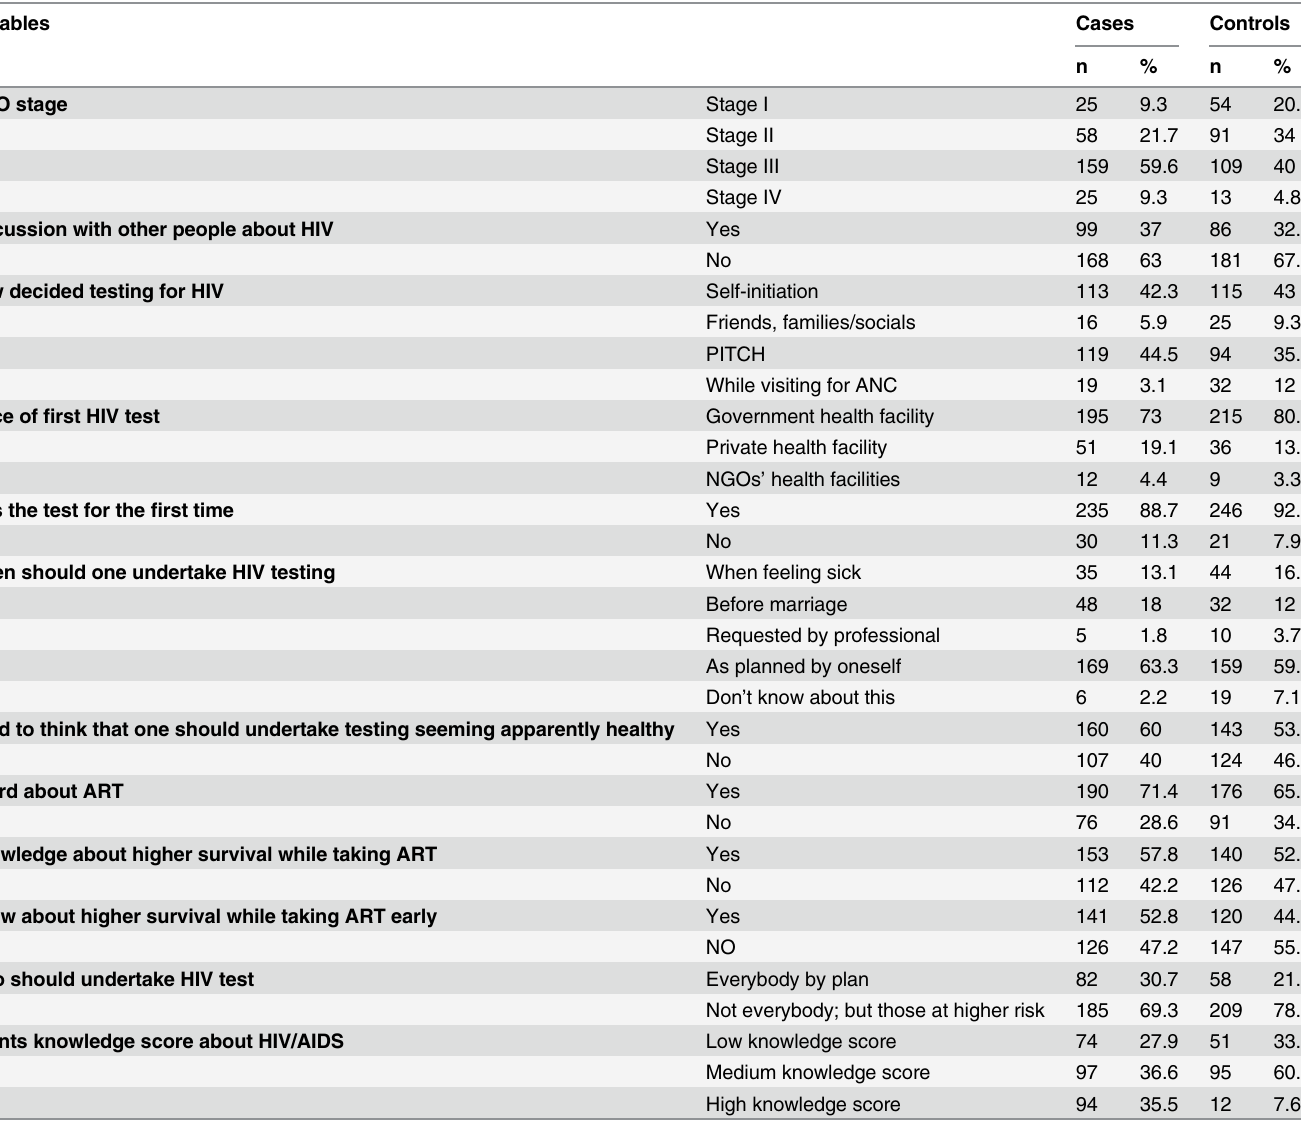
Table 2. Immunological, clinical and behavioral characteristics of adult PLHA who undertake initial CD4 count at Bahirdar FHRH, Northern Ethiopia.